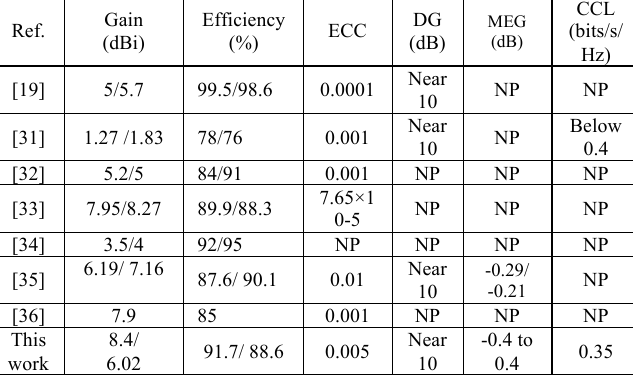
T ABLE IV. Comparison of MIMO performance parameters of the proposed MIMO antenna with the dual-band MIMO antenna mentioned in Table